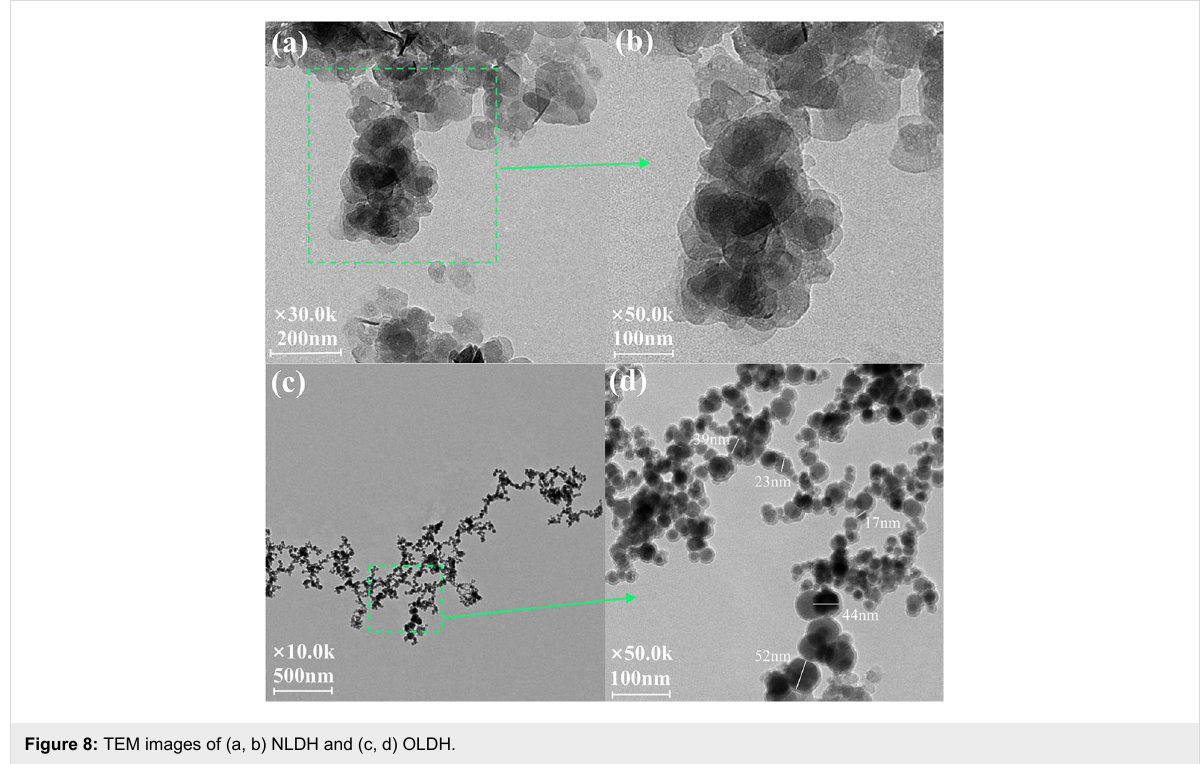
Figure 8: TEM images of (a, b) NLDH and (c, d) OLDH.